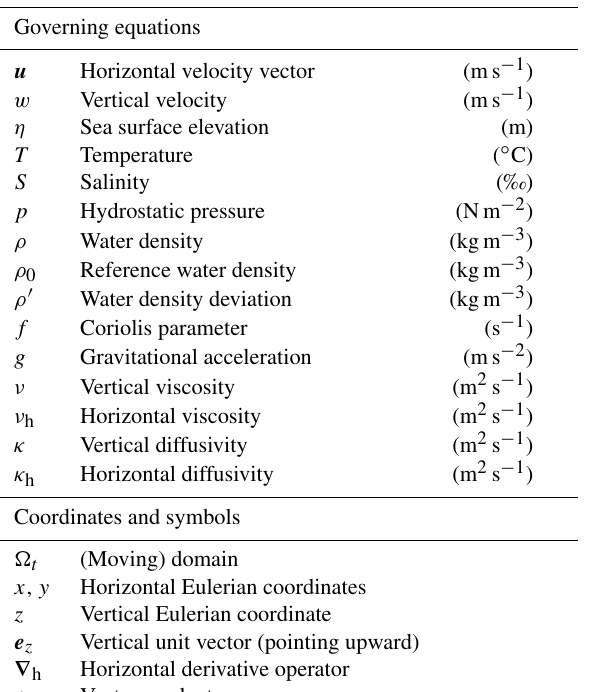
Table 1. Symbols and physical variables defined in this paper.